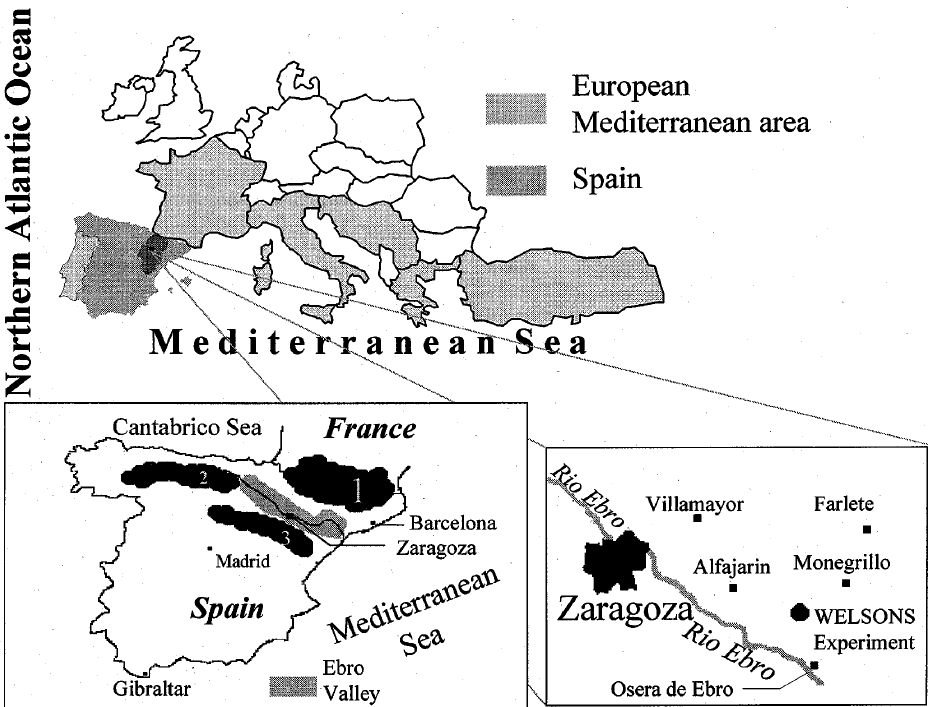
Fig. 1. Map of the area studied. Top shows the Aragon region in dark grey within Spain. The WELSONS experiment site is situated between Osera de Ebro and Monegrillo, at about 40 km from Zaragoza in the Ebro Valley. The bottom-right map allows us to visualize the specific geography of this region, with the Pyre´ ne´ es Mountains (1) which